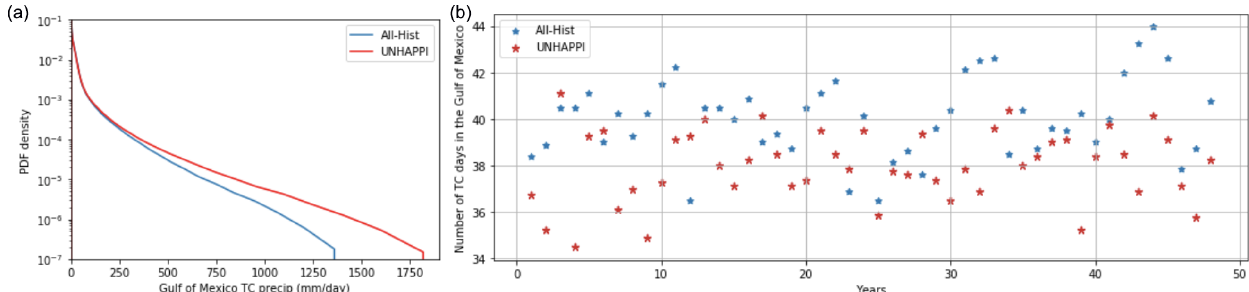
Figure 11. (a) Conditional PDF for tropical cyclone precipitation in the Gulf of Mexico using fastKDE (O’Brien et al., 2016); (b) number of tropical cyclone days annually in the Gulf of Mexico, shown for 50 years of All-Hist and UNHAPPI.